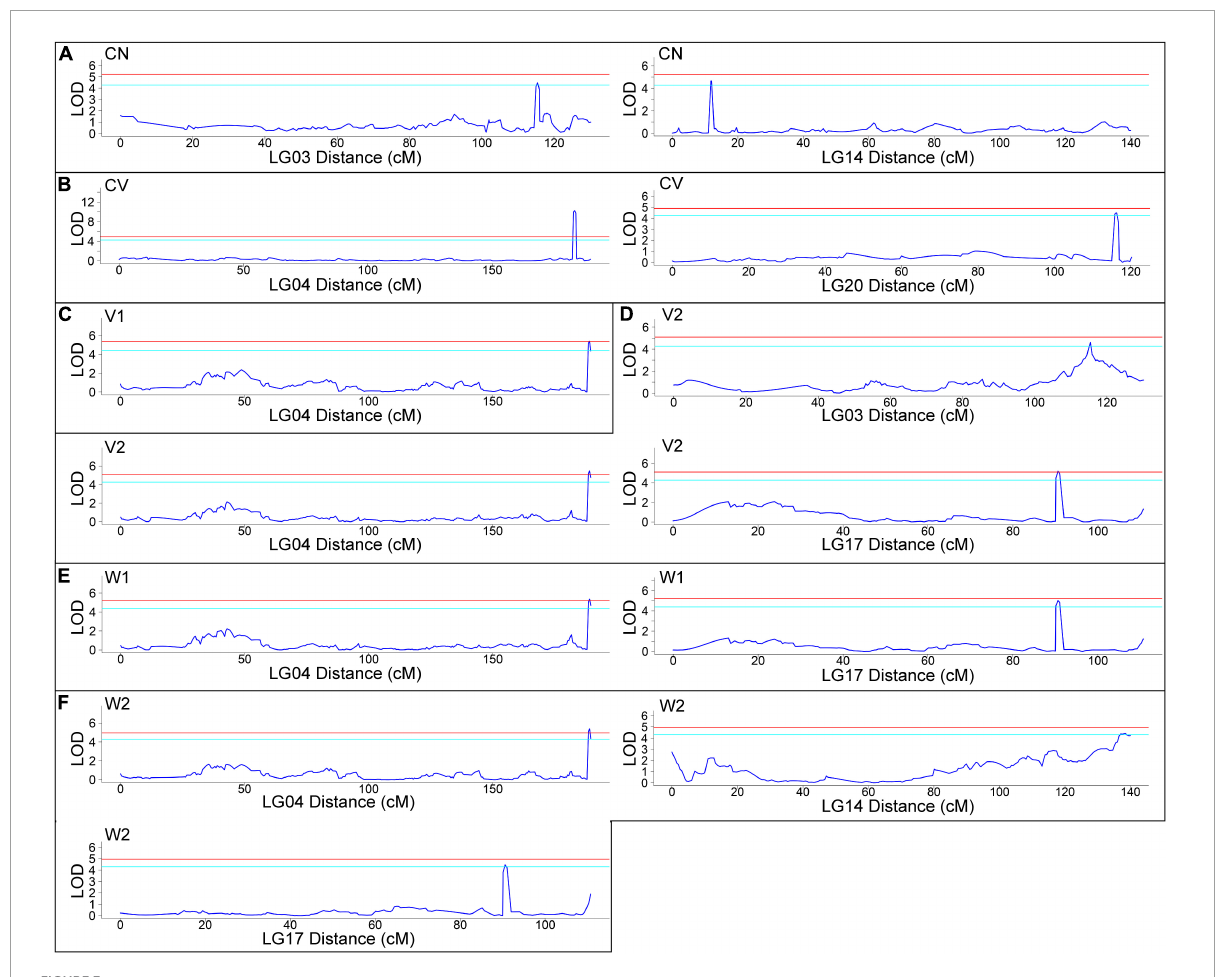
FIGURE3 Quantitative trait loci (QTL) mapping of six traits related to fruit size from 102 F 2 plants and two parents (AG and Hubbard). (A) Cell number (CN), (B) cell volume (CV), (C) fruit volume (V1), (D) fruit weight (W1), (E) fruit volume without seeds and placenta (V2) and (F) fruit weight without seeds and placenta (W2). The red line means a 0.01 (99% confidence) threshold level and the azure line means a 0.05 (95% confidence) threshold level for a candidate